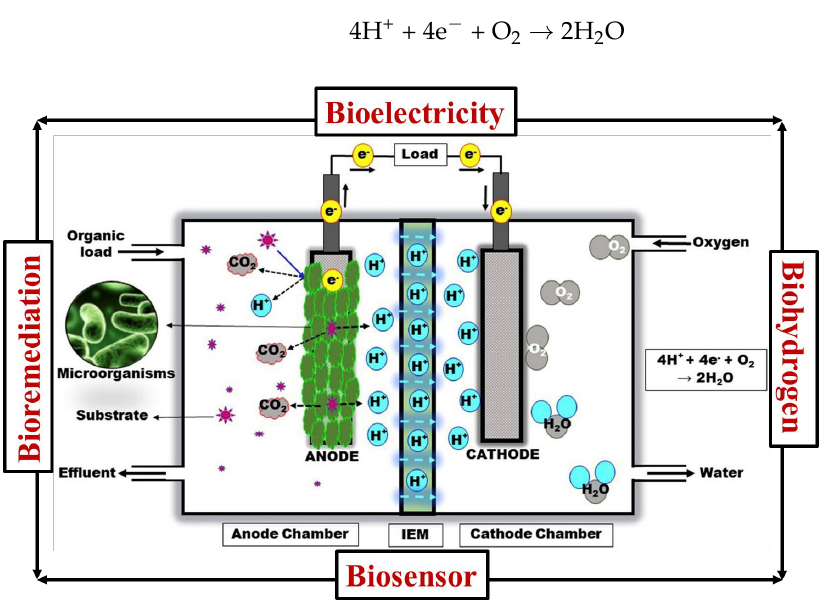
Figure 1. A schematic representation of dual-chambered microbial fuel systems reaction process and applications. Reproduced from [34], with permission from Elsevier, 2019.